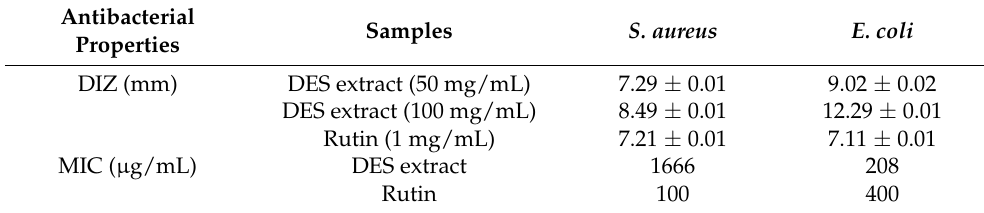
Table 2. The antibacterial activities of DES extracts.